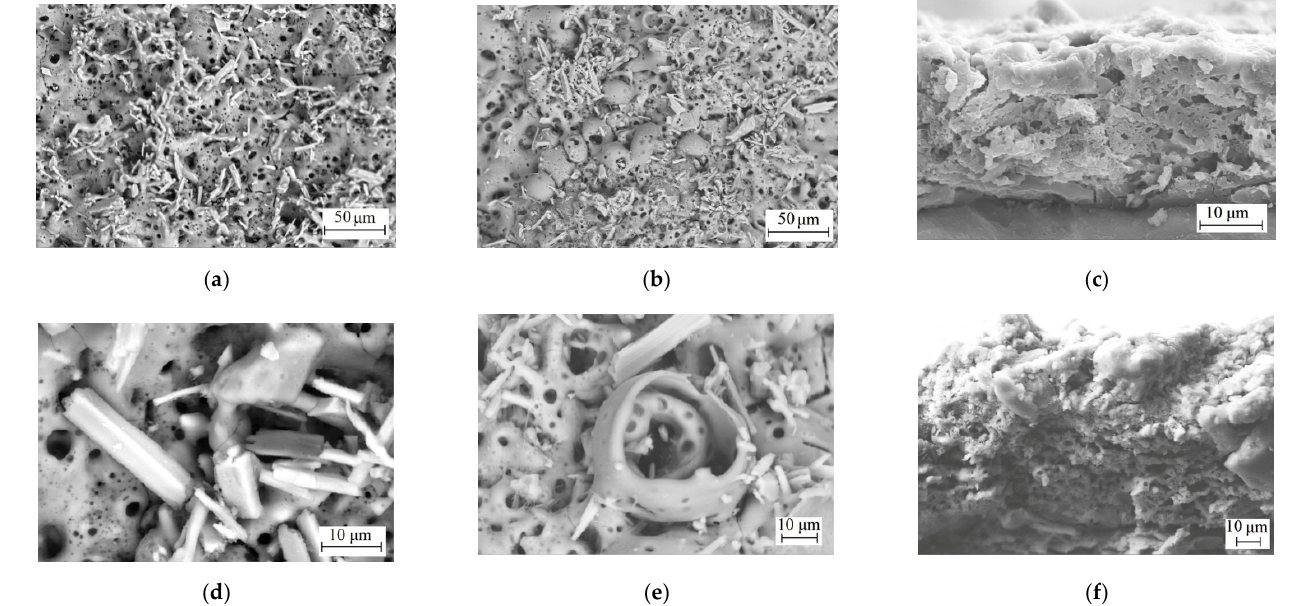
Figure 3. SEM images of the surface ( a , b , d , e ), and cross-sections ( c , f ), of W-coatings deposited at 350 V ( a , d , c ) and 500 V ( b , e , f ).